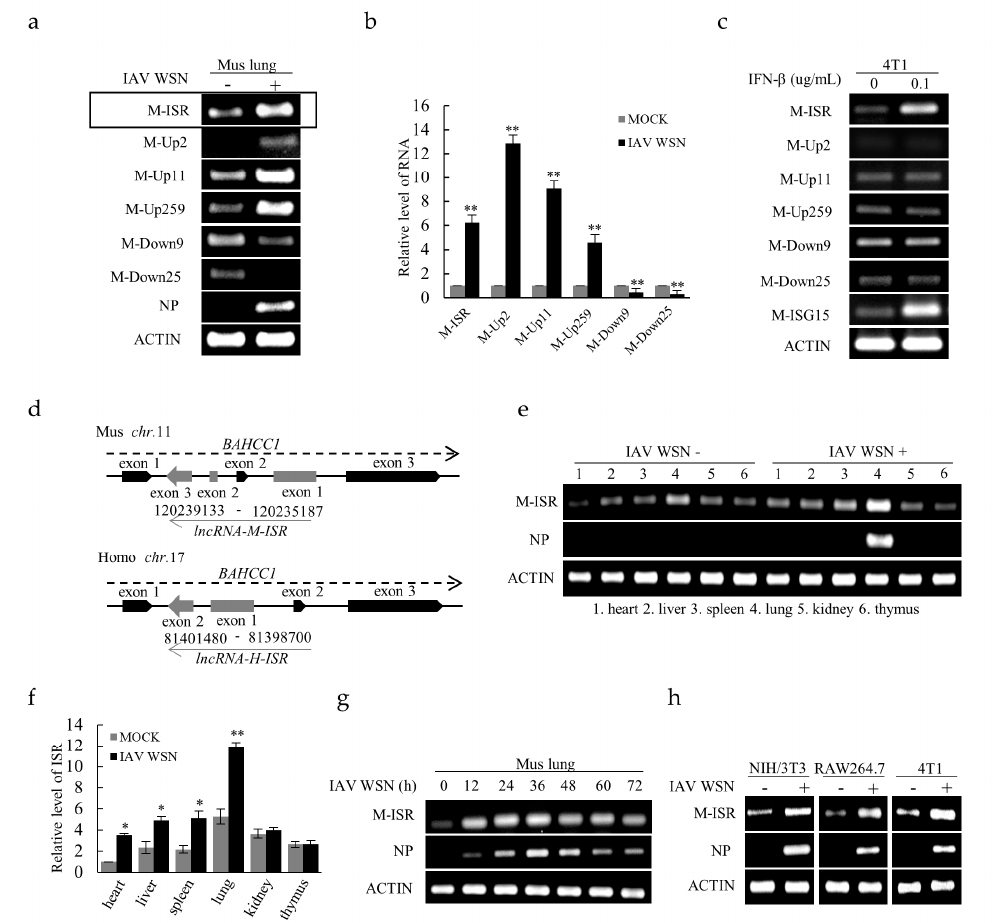
Figure 1. Induction of long noncoding RNA (lncRNA) expression in response to influenza A virus (IAV) infection. ( a,b ) Differential expression of six selected lncRNAs in mouse lung infected with